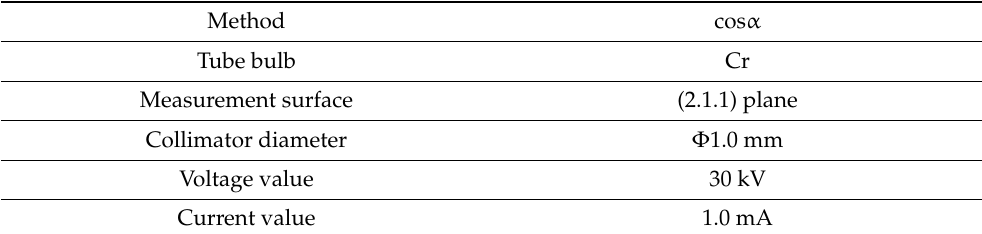
Table 3. Residual-stress measurement